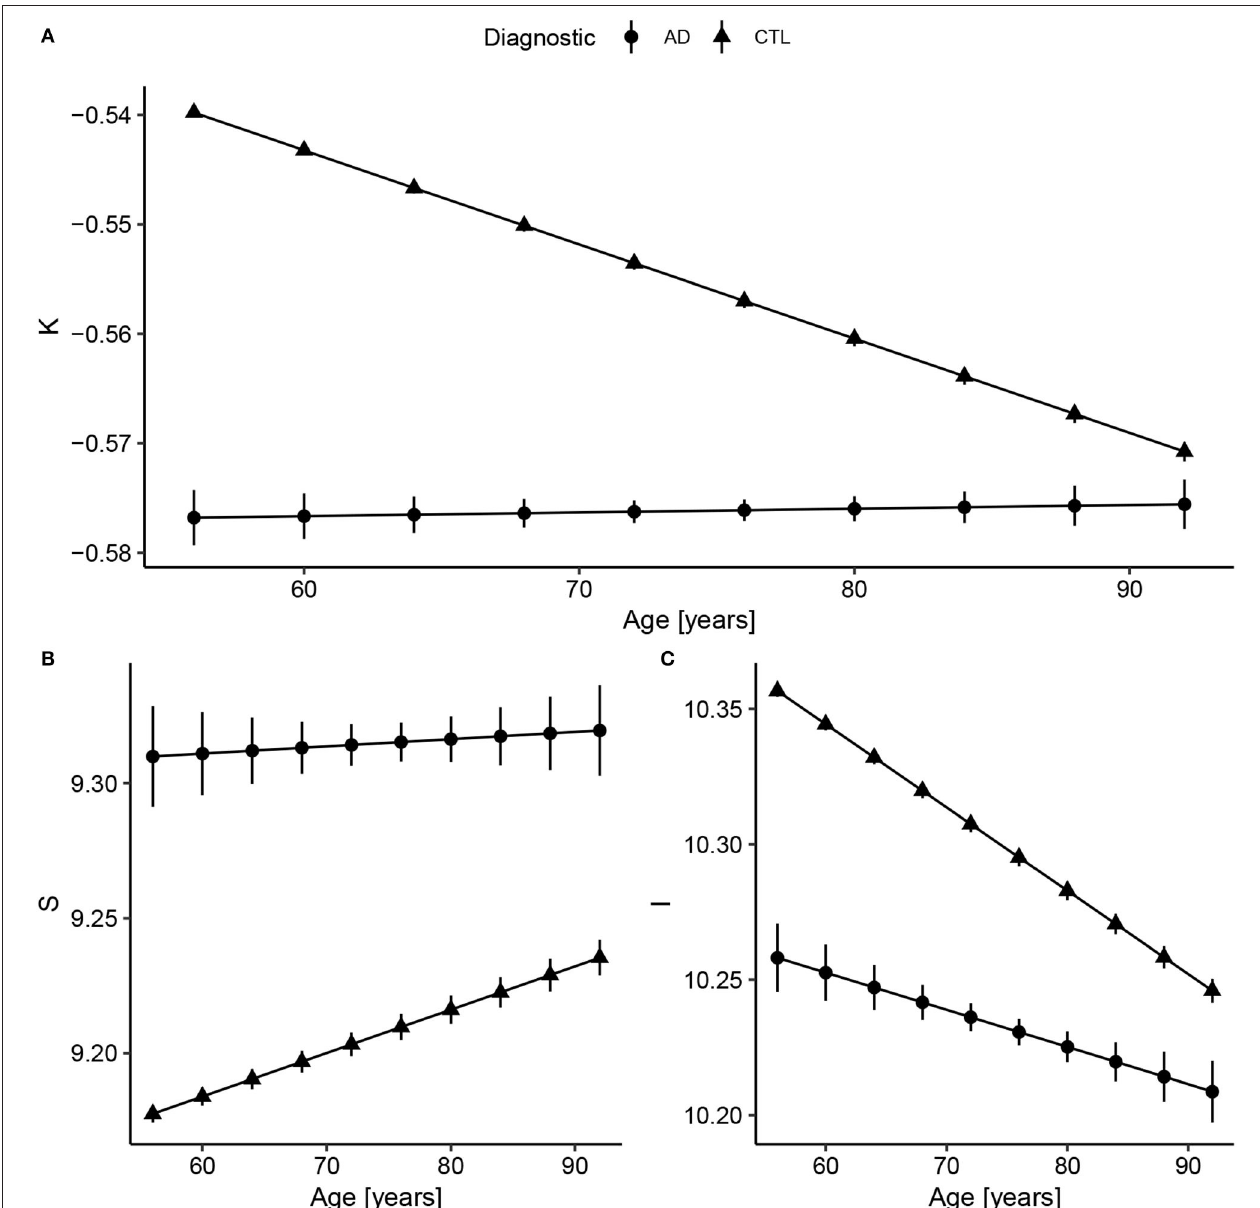
FIGURE 3 | Fitted values extracted from the linear regression model after data harmonization. Bars represent the 95% CI. Complete summary of linear models in Supplementary Material . (A) Concerning K, Alzheimer’s Disease (AD) has a shallow slope, meaning small changes with Age. Compared to healthy controls, AD values of K are almost constant and similar to older subjects (AD slope p < 0.0001 and CTL slope p < 0.0001; pairwise comparison estimate 0.00090, p < 0.001). − (B) For S, the AD and CTL patterns have similar intercepts, but statistically different slopes (AD slope p = 0.004 and CTL slope p < 0.0001; pairwise comparison estimate 0.0013, p = 0.004). (C) For I, that reflects brain volume, CTL has a decreasing volume with aging, while AD has a smaller slope (AD slope p < 0.0001 and CTL slope p < 0.0001; pairwise comparison estimate 0.0017, p < 0.001). The curves for the AD group were extended to early ages to ease the −